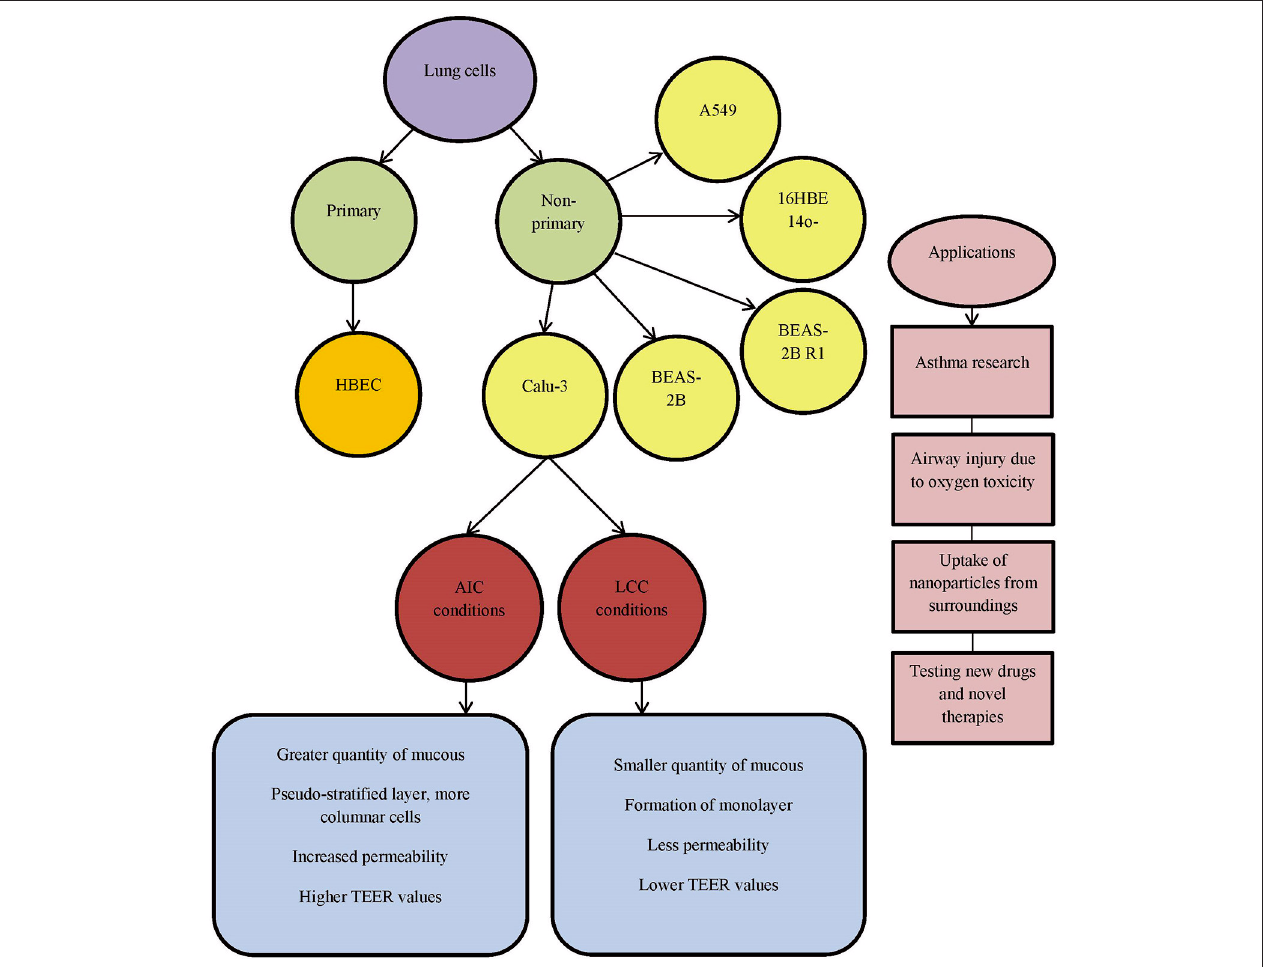
FIGURE 1 | List of commonly used lung cell lines. AIC, air-interfaced culture; LCC, liquid-covered